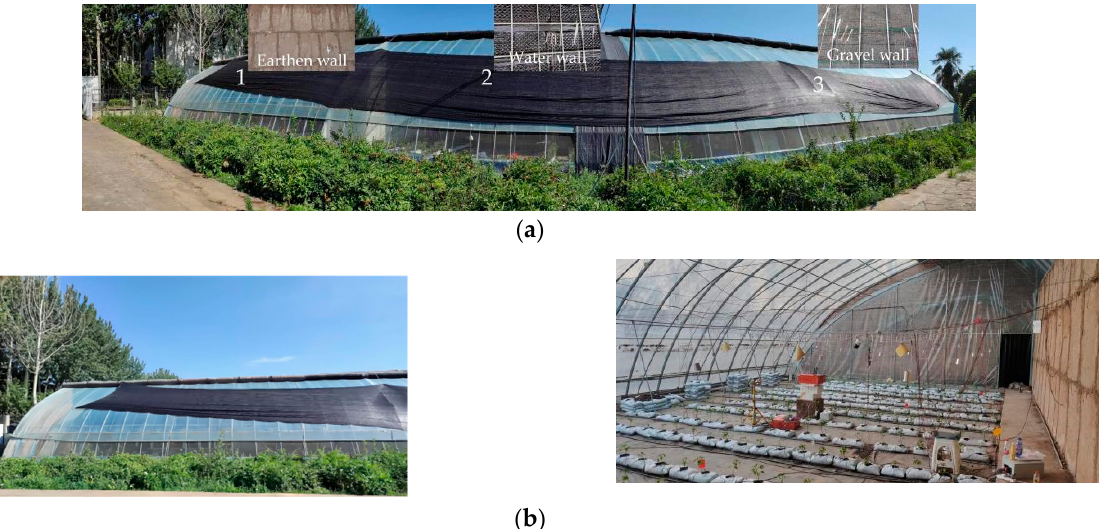
Figure 1. CSG real figure. ( a ) is a full-frontal view of the experimental CSG. ( b ) Earthen wall module of experimental greenhouse.